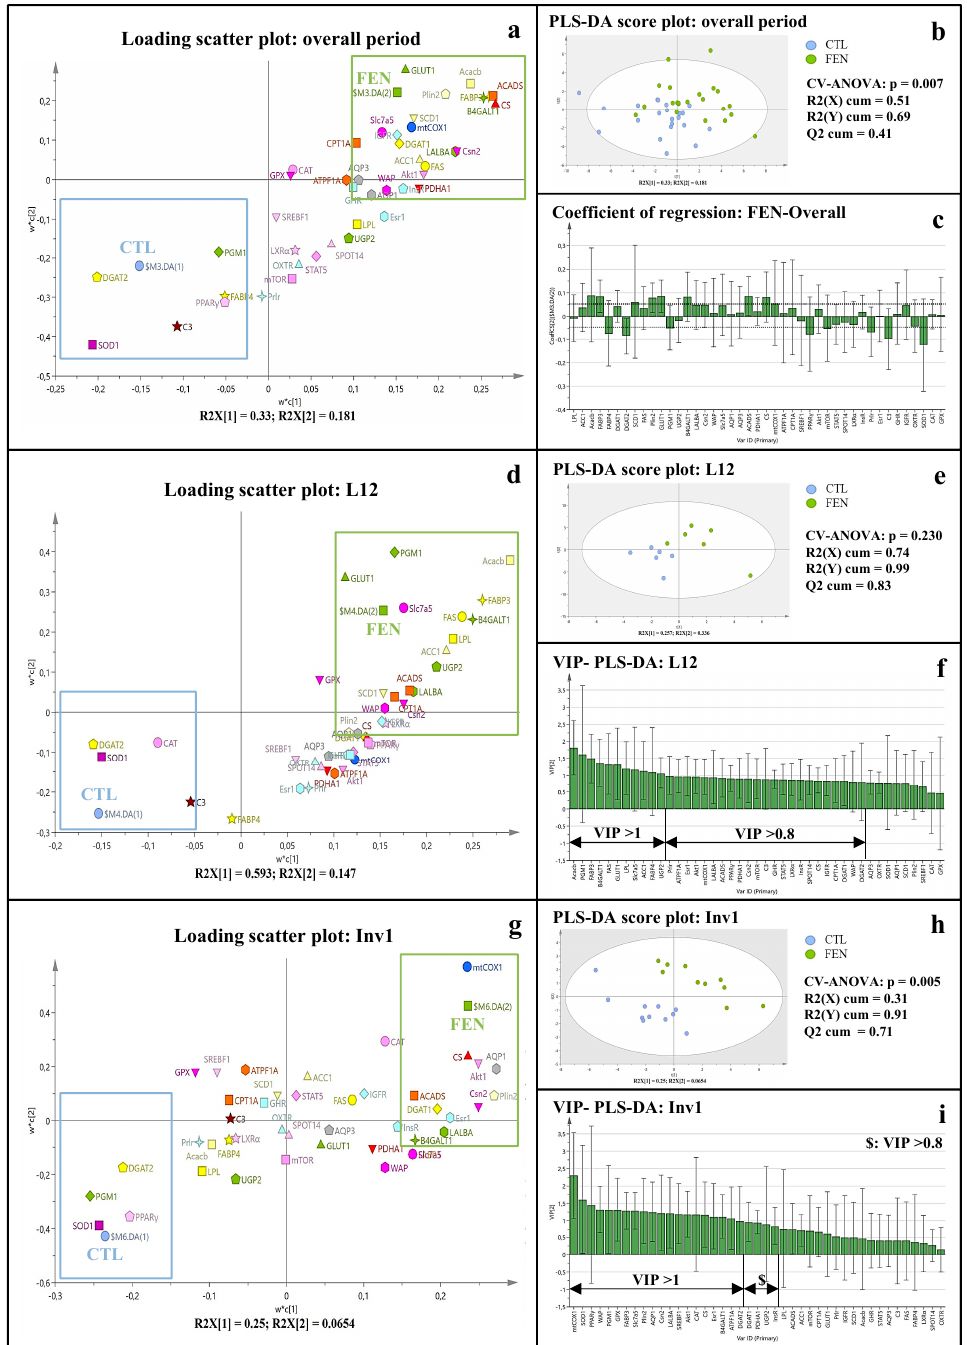
Figure 4. Fenugreek supplementation impacts mammary gland gene expression in CTL and FEN groups, regardless of lactation stage. PLS-DA score plot (on the first two components) built on all normalized variables (that have been mean-centered and scaled by lactation time point), revealed an effect of fenugreek supplementation on mammary gland gene expression during the entire period of lactation ( b ), at L12 ( e ) and Invl ( h ). PLS-DA loading plot presented clusters of variables highly associated to FEN and CTL groups’ overall lactation ( a ), at L12 ( d ) and Invl ( g ) with high regression coefficient (i.e., high prediction vector) for FEN class overall lactation ( c ) or high VIP scores on the two first PLS-DA components, at L12 ( f ) and Inv1 ( i ). CTL: control diet group and FEN: fenugreek-supplemented diet group throughout the lactation period. L12 and L18: post-natal day of lactation 12 and 18, InV1: first day of